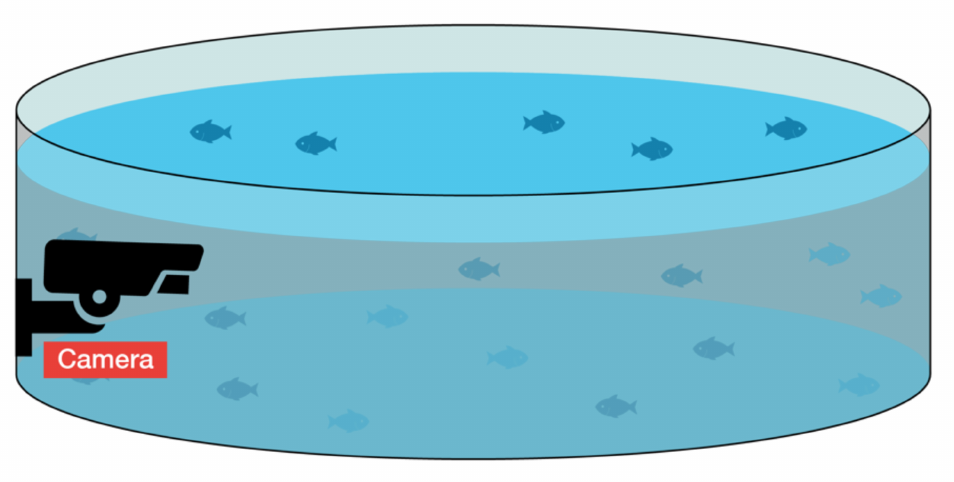
Figure 29. Data acquisition